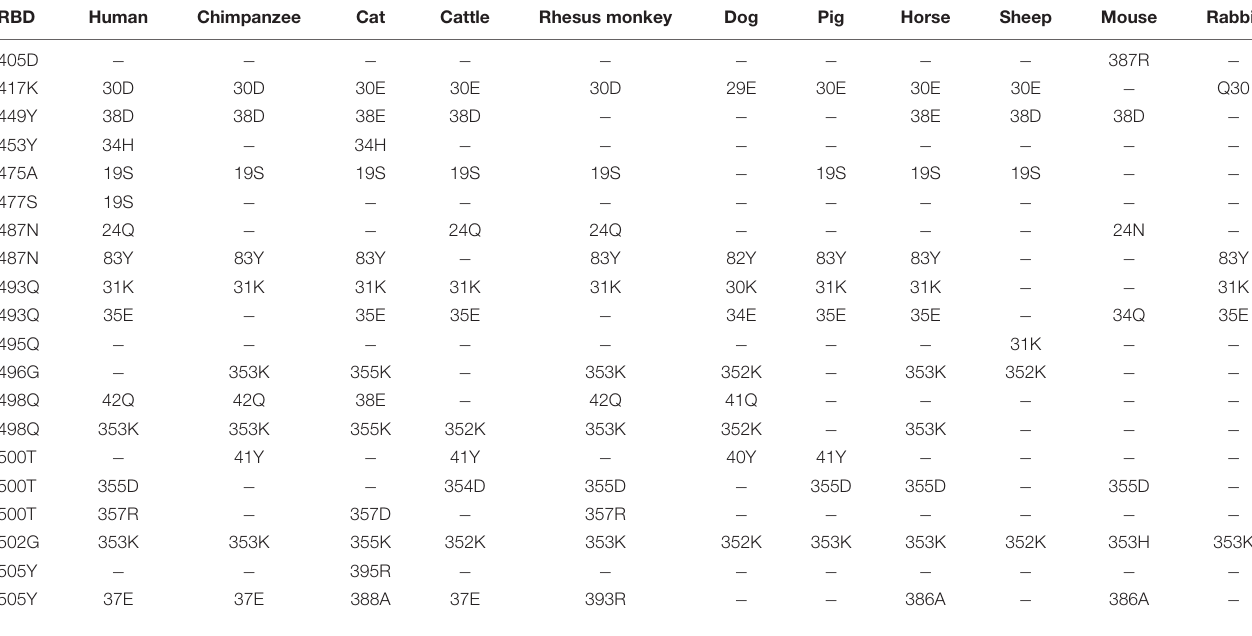
TABLE 3 | Potential interaction between the S protein receptor binding domain (RBD) and ACE2 of a variety of animals. RBD Human Chimpanzee Cat Cattle Rhesus